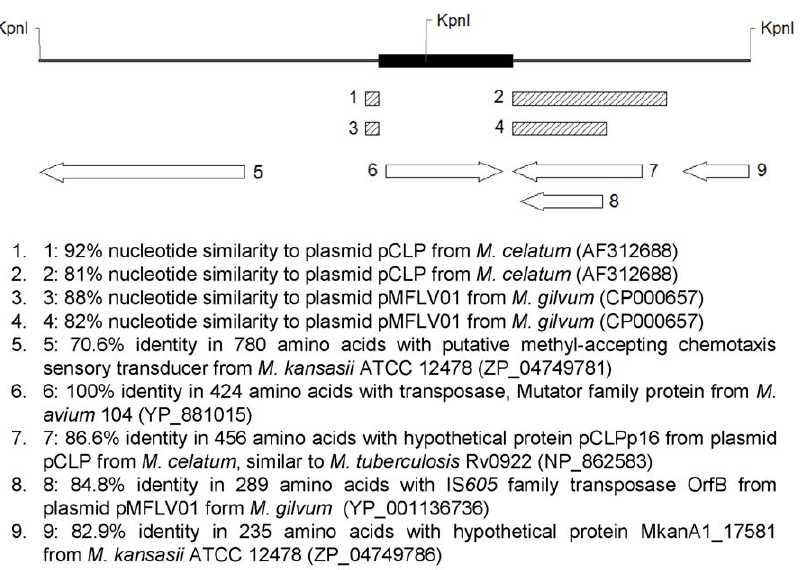
Figure 3. Gene features of the IS 1245 flanking regions in pMA100. The similarities identified in the 7,525-bp sequenced fragment of pMA100 are indicated. Similarities at nucleotide levels were identified using BLASTn and the regions of similarity are depicted as hatched bars; identities at amino acid level were identified using BLASTx and each region is shown as a white arrow, indicating the direction of transcription. Black bar localizes the IS 1245 element. KpnI restriction sites are indicated.